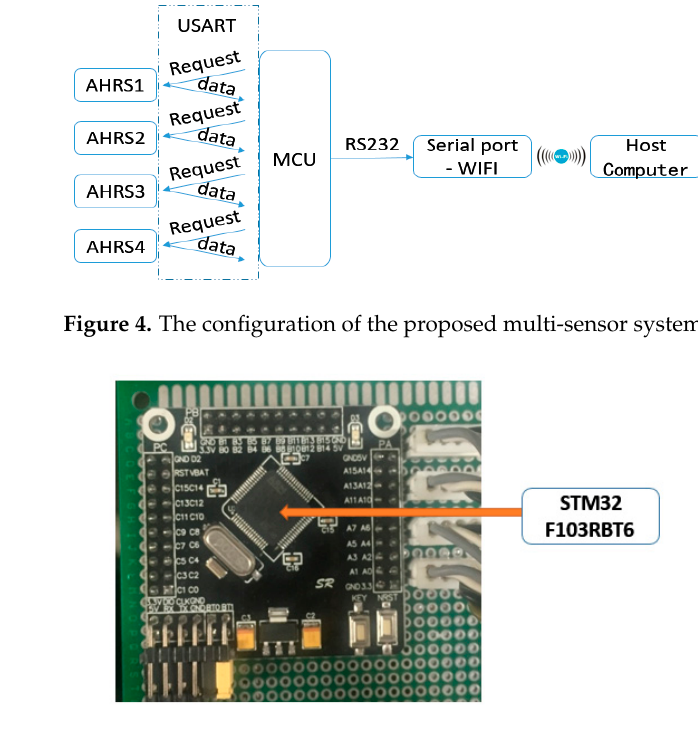
Figure 5. The hardware structure of a centralized MCU.